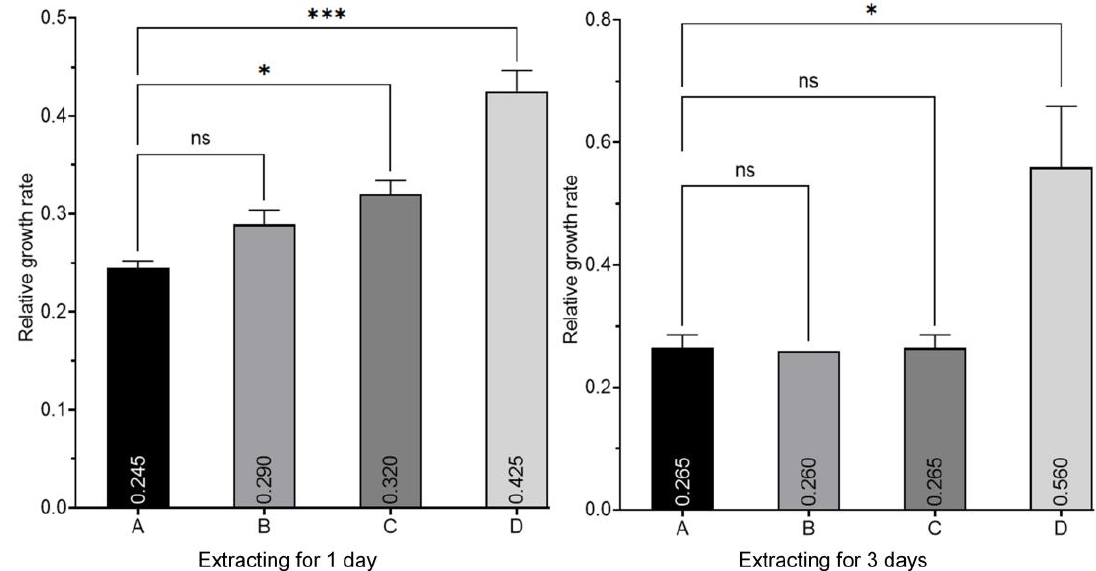
Figure 12. In vitro cell vitality tests of Mg alloy extracts on HUVECs. (A: bare Mg alloy; B: HF-Mg; C: PLLA (5)-HF-Mg; D: PLLA (10)-HF-Mg). Values are mean ± standard deviation ( n = 3). * p < 0.05, *** p < 0.001. ns: no significance.